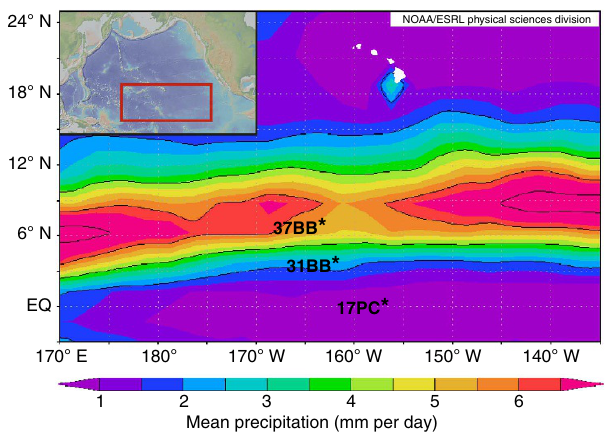
Figure 1 | Map of study area. ML1208 core sites 37BB, 31BB and 17PC (black stars) are shown relative to Hawaii (white islands), and the modern mean annual position of the ITCZ, illustrated by the maximum mean annual precipitation in mm per day (coloured contours). Inset shows the location of this map (red rectangle) in the broader context of the Pacific